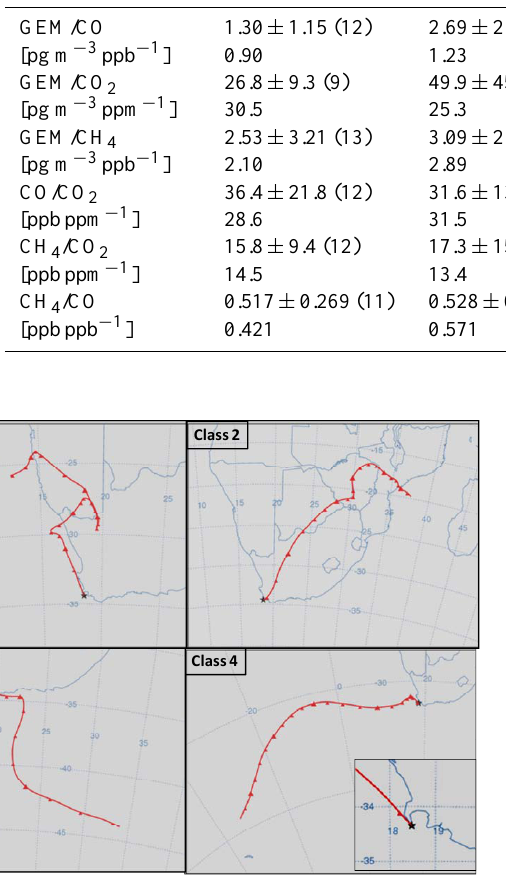
Fig. 3. Examples of the most frequent types of backward trajec- Fig. 3: Examples of the most frequent types of backward trajectories for pollution tories for pollution events observed at Cape Point: class 1: North- events observed at Cape Point: class 1: North-West Cape (with a subgroup 1(CT) West Cape (with a subgroup 1(CT) – Cape Town, trajectory from 27 – Cape Town, trajectory from May 27, 2008, 11:00 UTC); class 2: Gauteng, Mpumalanga, Botswana, Zimbabwe (trajectory from June 18, 2008, 15:00 UTC); May 2008, 11:00 UTC); class 2: Gauteng, Mpumalanga, Botswana, class 3: East Cape Province (trajectory from June 2, 2008, 14:00 UTC); class 4: Zimbabwe (trajectory from 18 June 2008, 15:00UTC); class 3: East marine with short section over the continent, i.e. local pollution (trajectory from July 26, 2008, 13:00 UTC). Cape Province (trajectory from 2 June 2008, 14:00UTC); class 4: marine with short section over the continent, i.e. local pollution (tra- jectory from 26 July 2008,